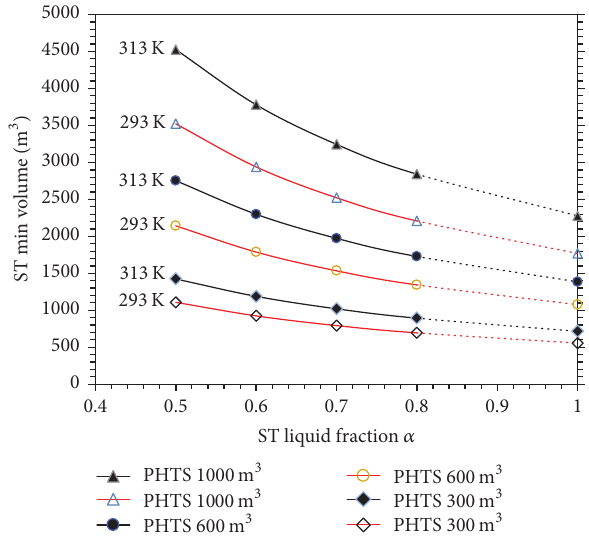
Figure 1: Minimum ST